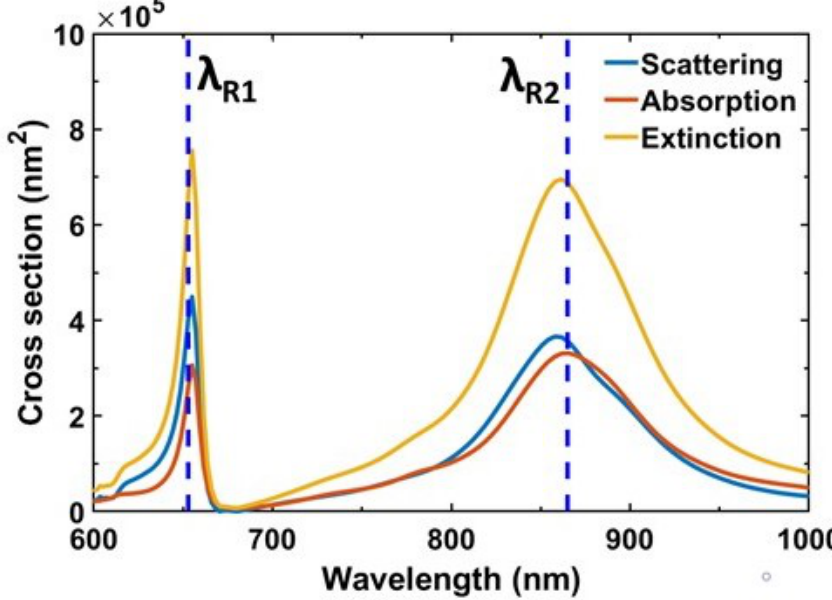
Figure 6. Simulated scattering, absorption and extinction (scattering + absorption) cross sections as a function of wavelength for the PA with optimized geometrical parameters. The vertical blue dashed lines identify the resonance wavelengths ( λ R 1 ≈ 653 nm, λ R 2 ≈ 865 nm). At both resonances, scattering and absorption cross sections are nearly identical, which justifies the critical coupling and minimum